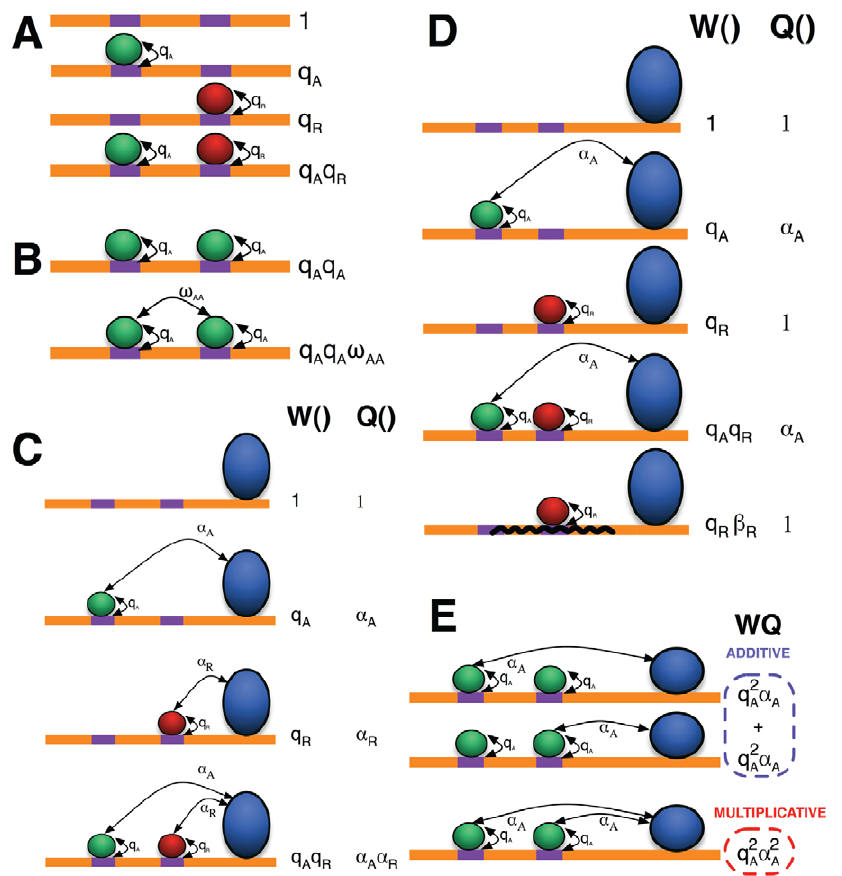
Figure 1. Statistical thermodynamic models of gene expression. (A) All possible molecular configurations of a CRM with two binding sites (purple), that may or may not be bound by a transcription factor (green circle=activator, red circle=repressor). The statistical weight W of each configuration is shown to its right. Each occupied site makes a contribution to W in a multiplicative fashion. (B) Cooperative DNA-binding is modeled by introducing a multiplicative factor ( v ) to the statistical weight of a configuration. The same configuration is shown along with its statistical weight W under a model with no cooperativity (top) and a model with self-cooperative DNA-binding (bottom). (C) Statistical weight contributions from TF- DNA interactions ( W ) and from TF-BTM interactions ( Q ) for each configuration, in the Direct Interaction model (blue circle=BTM). Each bound activator or repressor molecule contributes to the TF-BTM interaction term ( Q ) in a multiplicative fashion. The statistical weight also receives a contribution from BTM binding at the promoter; this term is not shown here. (D) Same as (C), but for the short range repression model. A bound repressor (red circle) does not have a direct interaction with the BTM. Also, there is one additional configuration allowed here, as compared to Direct Interaction: one where repressor is bound and ‘‘effective’’ in shutting down its neighborhood for binding at activator sites (bottom). The statistical weight (W) of this configuration is scaled by a factor of b R , reflecting the strength of the repressor to change the chromatin accessibility. (E) Two ways to model the action of multiple bound activators: ‘‘additive effect’’ (top 2 configurations) and ‘‘multiplicative effect’’ (bottom). The total statistical weight (W 6 Q) under each model is shown. In the former, only one bound activator may contact the BTM in any configuration, while the latter has no such restriction and leads to transcriptional